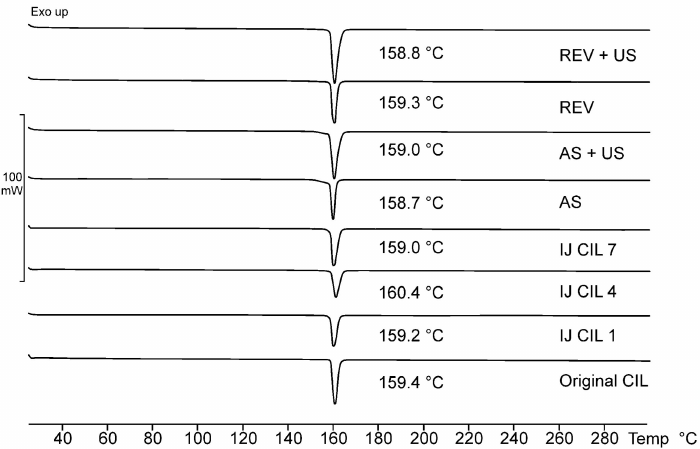
Figure 7. DSC thermograms of the crystallized